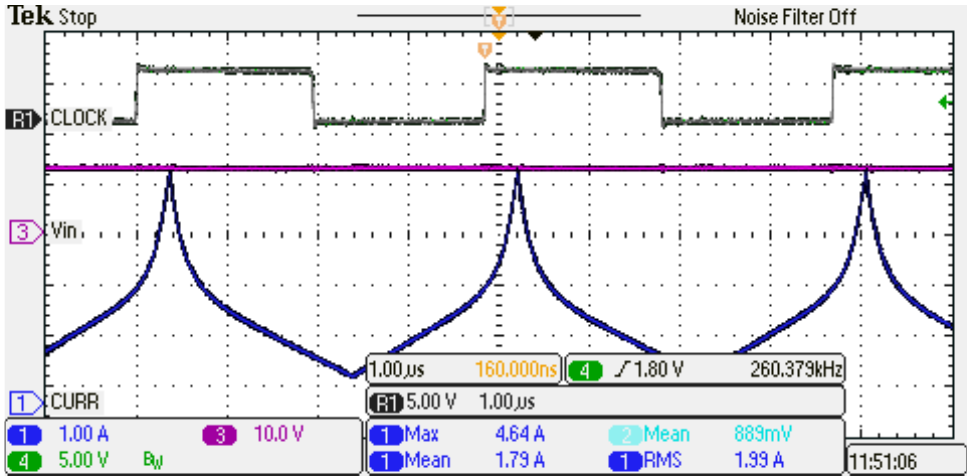
Figure 6. Current flowing through the inductor during the test for the characterization (bottom trace). The top trace, labelled as CLOCK, is the internal reference signal accessed by the pin “SYNC” of the EVM.